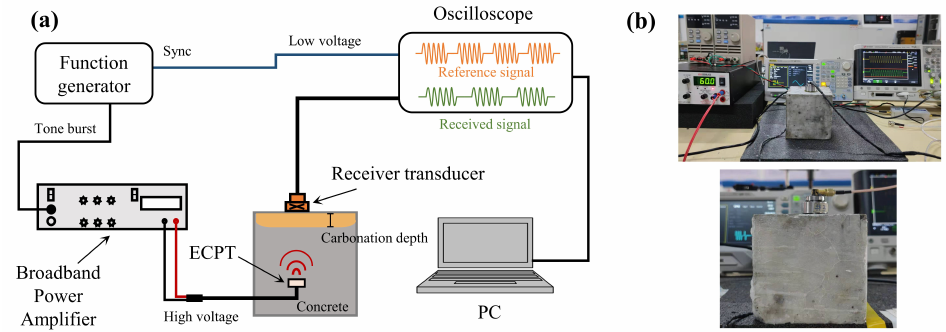
Figure 4. Experimental device: ( a ) connection of experimental instruments; ( b ) the photos of the experimental device.